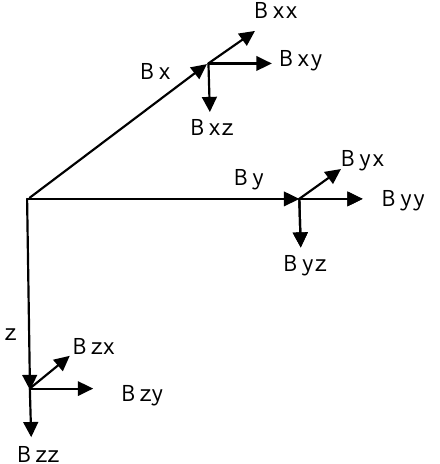
Figure 1. Schematic diagram of magnetic field component and magnetic gradient tensor. According to Figure 1, the components of the magnetic field vector along the x, y, and z directions are Bx , By , and Bz . The change rates of Bx in the x, y, and z directions are Bxx , Bxy , and Bxz . The change rates of By in the x, y, and z directions are Byx , Byy , and Byz . The change rates of Bz in x, y, and z directions are Bzx , Bzy , and Bzz . We convert the above data volumes into matrix representations. If B represents the magnetic field vector, the magnetic gradient tensor matrix G can be expressed as: